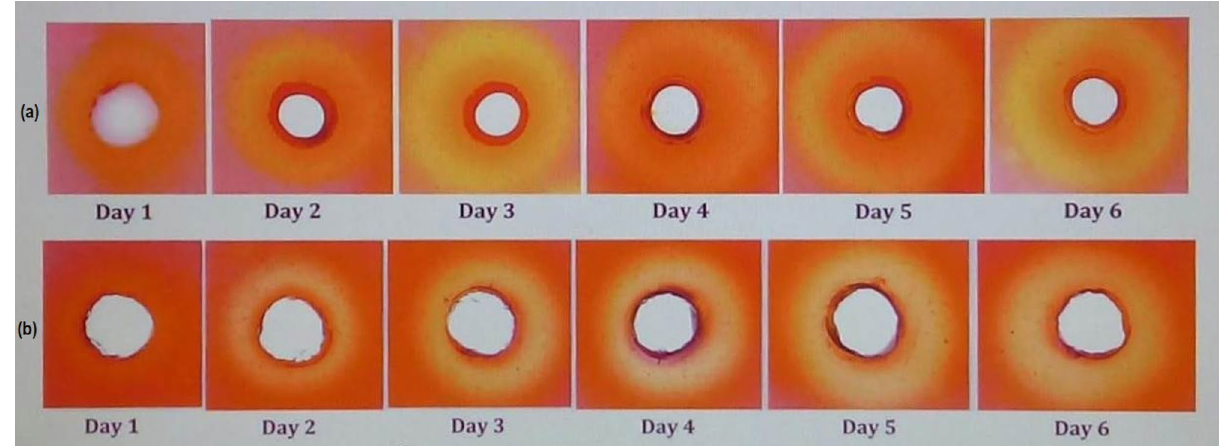
Figure 1. Detection of biodegradation of ( a ) CM-cellulose and ( b ) xylan by RSV consortium at various days of growth, as determined by agarose well diffusion assay.